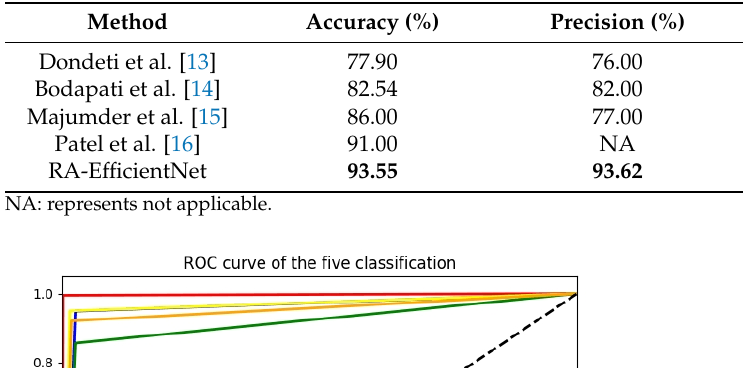
Table 8. Comparison with existing works for DR severity grades on APTOS 2019 dataset.